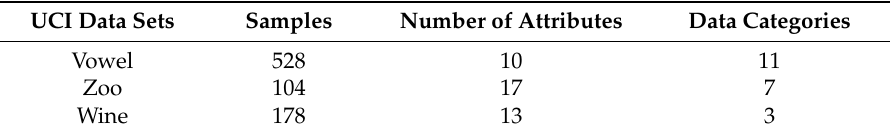
Table 1. The features of the University of California Irvine (UCI) data